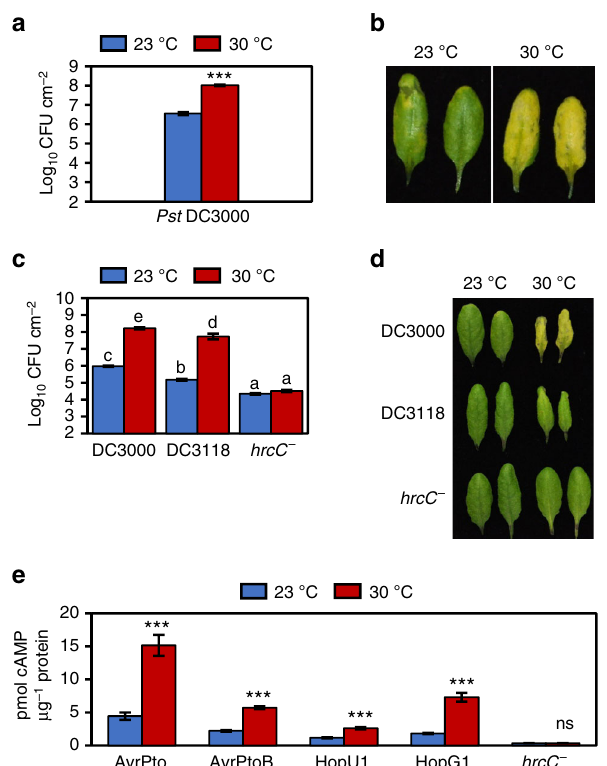
Fig. 1 Enhanced growth of Pst DC3000 in planta at 30 °C requires the type III secretion system and results in elevated levels of effector translocation. a Bacterial growth in plants ( n = 4) 3 days after syringe-in fi ltration with Pst DC3000. b Disease symptoms at three dpi for plants in ( a ). c Bacterial growth in plants ( n = 4) 3 days after syringe-in fi ltration with Pst DC3000, Pst DC3118 (coronatine-de fi cient mutant) or hrcC − (T3SS-de fi cient mutant) strains. d Disease symptoms three dpi for plants in ( c ). e Amount of cyclic AMP (cAMP) generated in temperature-acclimated plants syringe- in fi ltrated with Pst DC3000(P nptII ::avrPto-CyaA ) ( n = 4), Pst DC3000(P tac